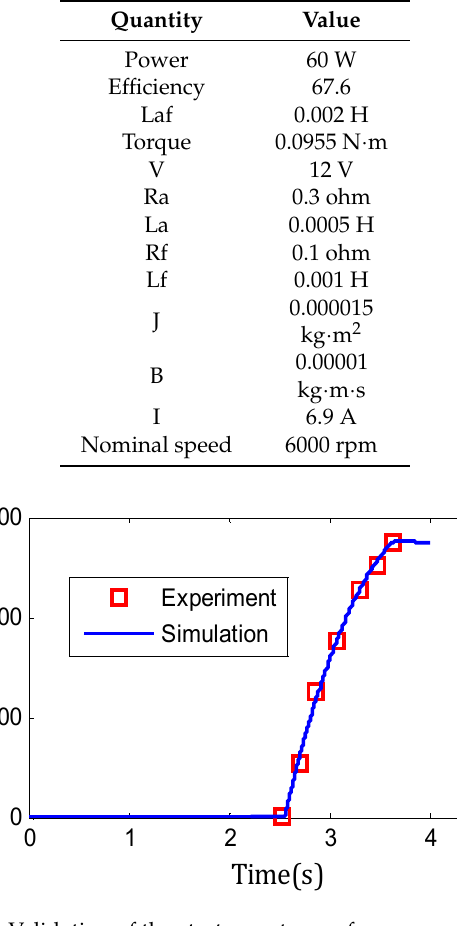
Figure 5. Validation of the starter motor performance model [16].